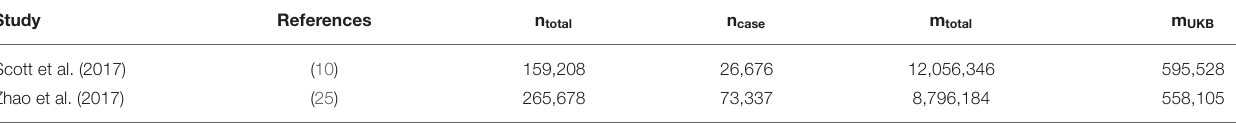
TABLE 1 | Type 2 diabetes studies with available GWAS summary statistics independent of UKB. Study